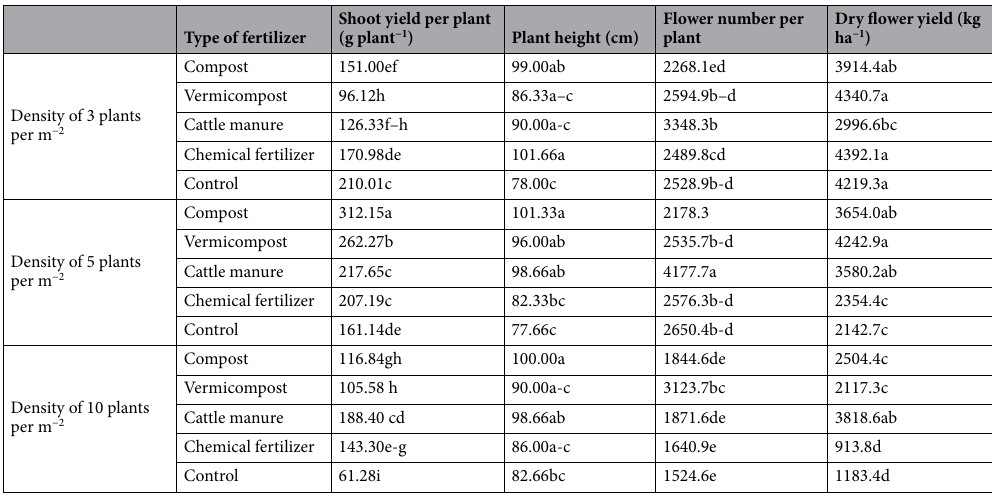
Table 4. Mean comparisons of interaction of different densities and organic and chemical fertilizers application on some characteristics and yield of Echium amoenum. In each column, means followed by the same letters are not significantly different ( p ≤ 0.05), based on Duncan’s multiple range